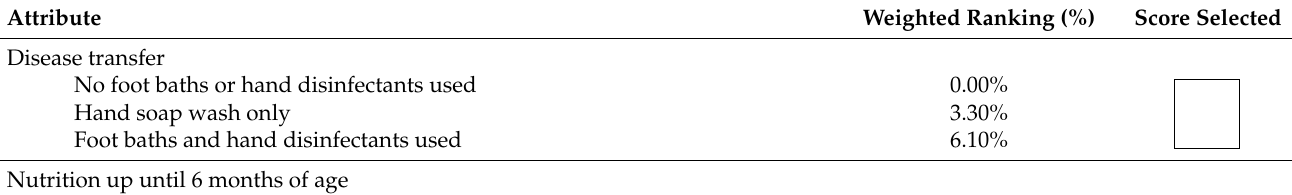
Table 4. A value model (%) for rating the welfare of lion cubs used in tourism (wildlife interaction